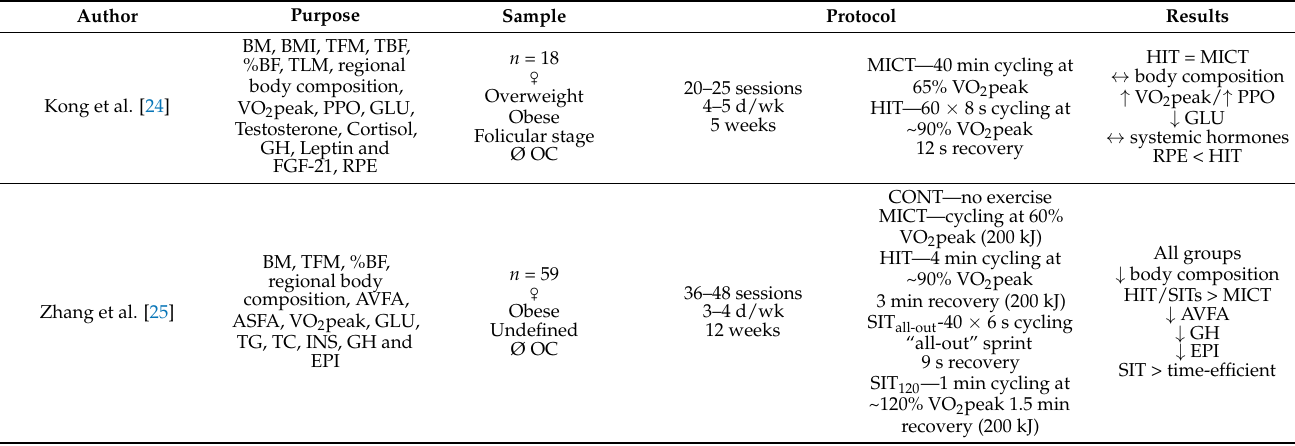
Table 1. Characteristics of studies